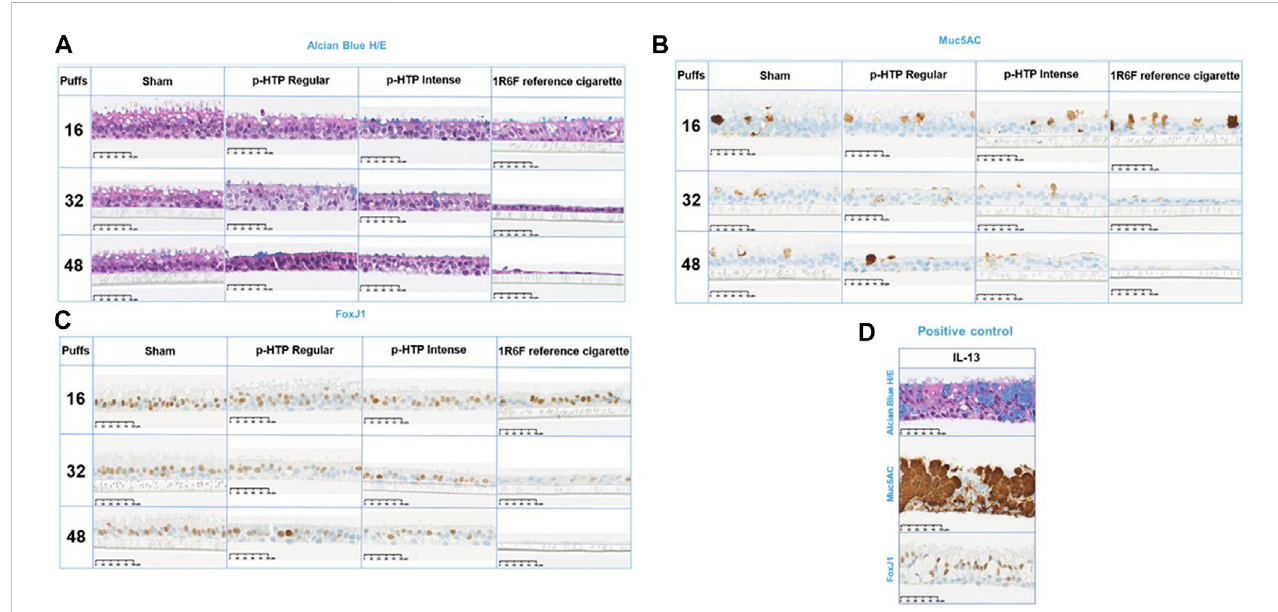
FIGURE 3 Representative histological images of the tissues exposed to 16, 32 and 48 puffs of air (sham), p-HTP Regular aerosol, p-HTP Intense aerosol or 1R6F referencecigarettesmoke,harvestedattheendofthe28 daysrepeatedexposureexperimentalperiod.FixedtissuesliceswerestainedwithAlcianBlueandH/ E (A) , Muc5AC (B) and FoxJ1 (C) . A subset of tissues were treated with IL-13 as a positive control (D) . Sham: n = 1 per condition; test products: n = 2 per condition; IL13: n = 3.